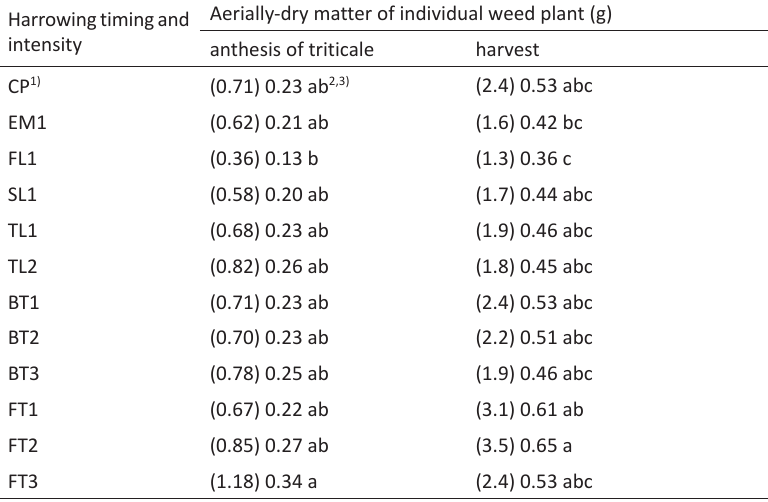
Table 5. Effect of weed harrowing on aerially-dry matter of individual weed plant at anthesis of triticale and at full maturity of triticale-lupin mixture. Means averaged over